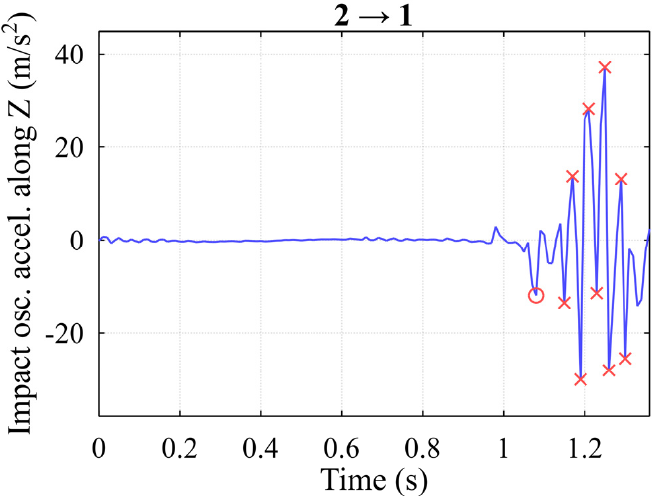
Figure 17. Example of an extracted initial impact event (here the red circle indicates the starting point, and the circles indicate the resulting peak values of the potential impacts).